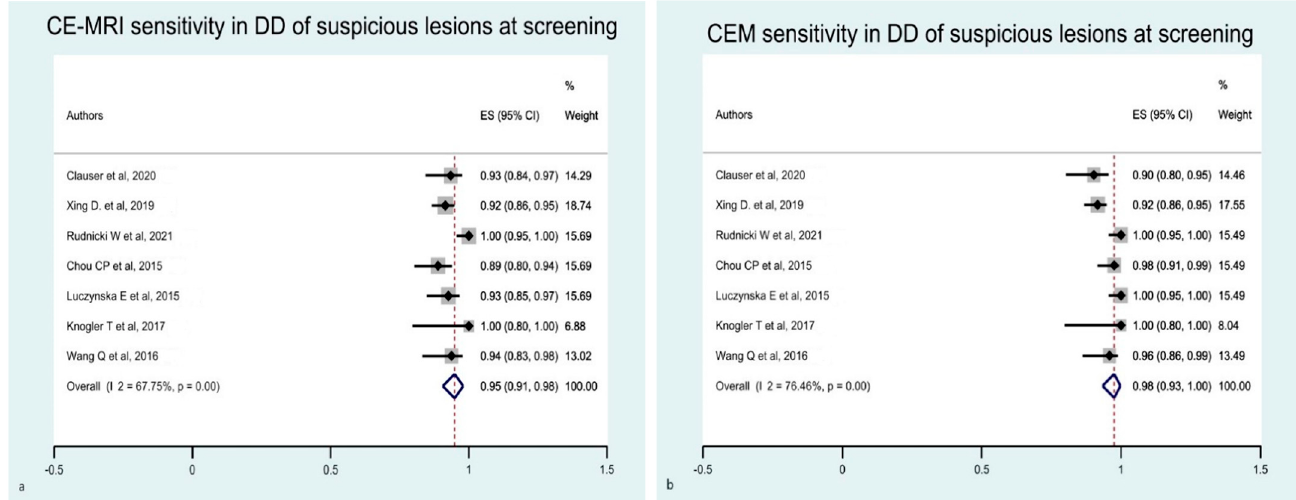
Figure 6. Forest plot of the estimated pooled sensitivity of breast CE-MRI ( a ) and CME ( b ) for the differential diagnosis of suspicious lesions at screening. The estimated pooled sensitivity of CE-MRI ( a ) was 0.95 (95% CI 0.91 – 0.98), with a moderate heterogeneity (I 2 = 67.75% p = 0.001). The estimated pooled sensitivity of CME (b ) was 0.98 (95% CI 0.93 – 1.00), with a high heterogeneity (I 2 = 76.46% p = 0.001) [16,17,18,21,28,29,30].